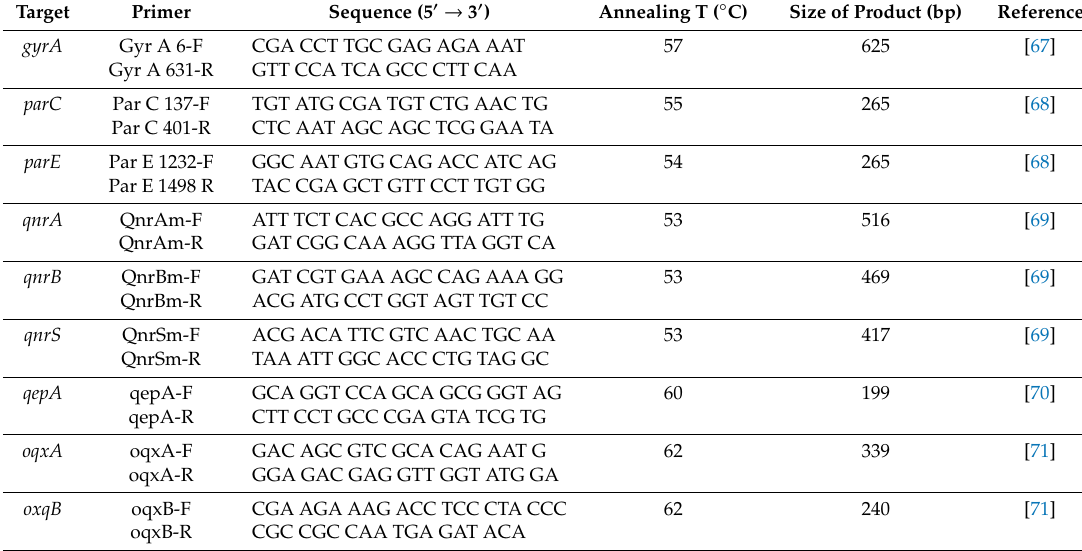
Table 3. Overview of the PCR primers used in this study to detect chromosomal (QRDR) and plasmid quinolone resistance (PMQR)